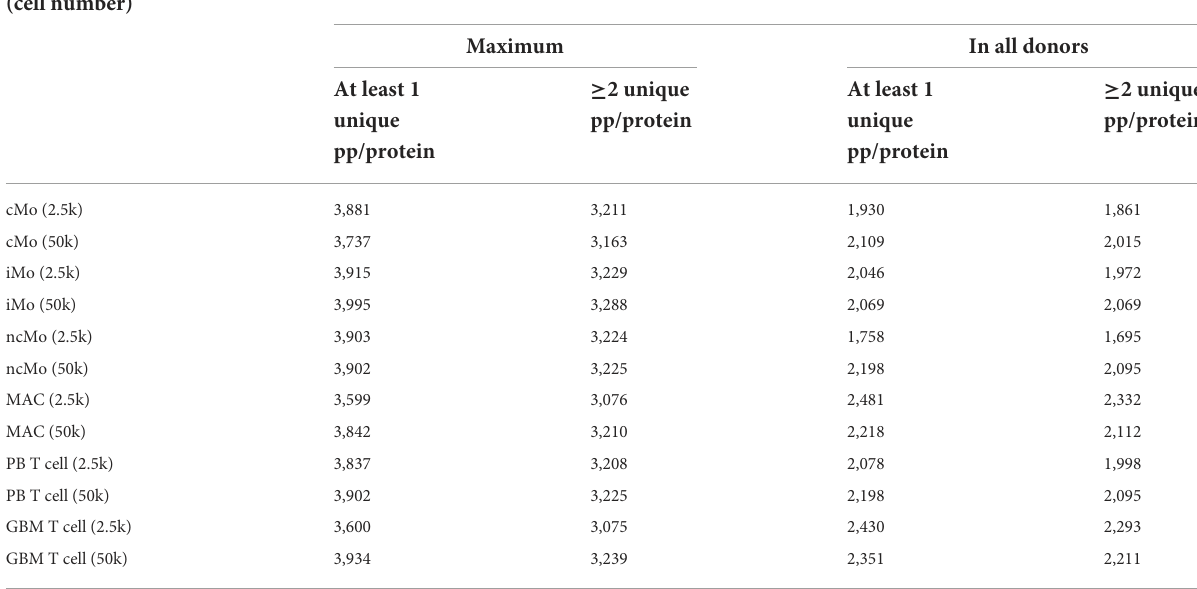
TABLE 1 Number of proteins identified per condition (2.5 and 50k) and cell type (cMo, iMo, ncMo, MAC, PB T cells, GBM T